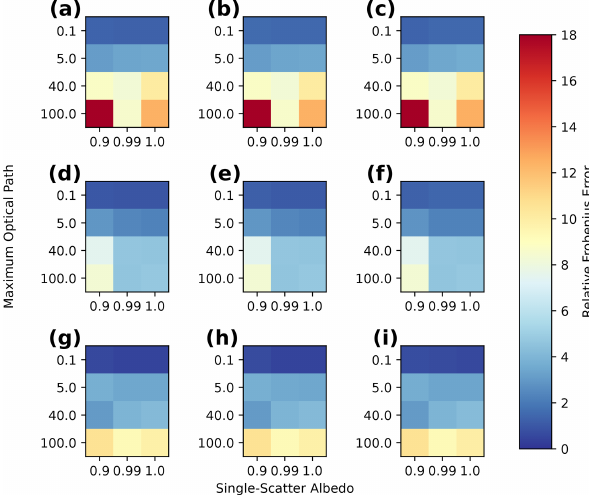
Figure 16. Similar to Fig. 15 but using base states that are plane- parallel, horizontally homogeneous extinction fields. Note the dif- ference in color scale from Figs. 10 and 15. Panels (a) , (b) , and (c) have isotropic phase functions. Panels (d) , (e) , and (f) have Mie phase functions, and panels (g) , (h) , and (i) have Mie phase func- tions with a reduced angular resolution (see text for details). Pan- els (a) , (d) , and (g) have a black surface. Panels (b) , (e) , and (h) have Lambertian surface albedos of 0.2, while panels (c) , (f) , and (i) have Lambertian surface albedos of 0.7.